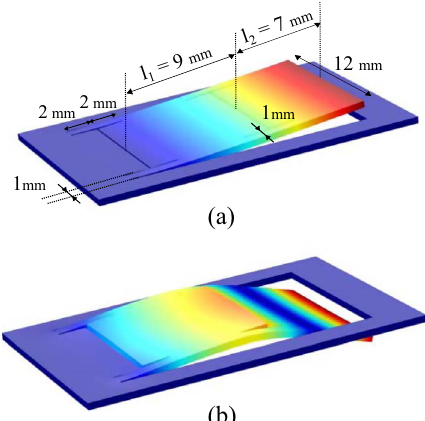
Figure 4. (a) Absorption coef fi cient and (b) impedance as a Figure 5. (a) First ( f = 709 Hz) and (b) second ( f = 4412 Hz) function of the normalized frequency when one (mono-articu- mode of the cantilever beam with the I-cut shaped slits, as lated beam, in magenta) or two (bi-articulated beam, in blue) computed using a fi nite elements method (Comsol). l 1 and l 2 are modes are considered. For the fi rst mode, the parameters are the the lengths of the two parts of the same that in Figure 2. The second mode is de fi ned by x x k e k e /8 and d d . b , b 2 b 2 = b b b2 = 6.05 2 = 2.5